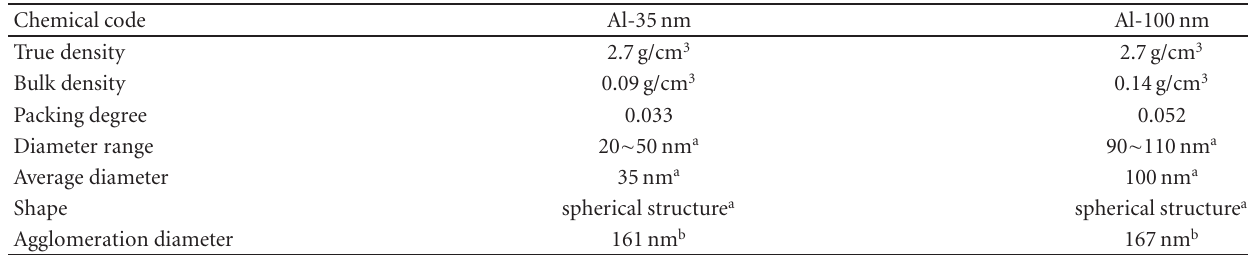
Table 1: The specifications for the aluminum powders.